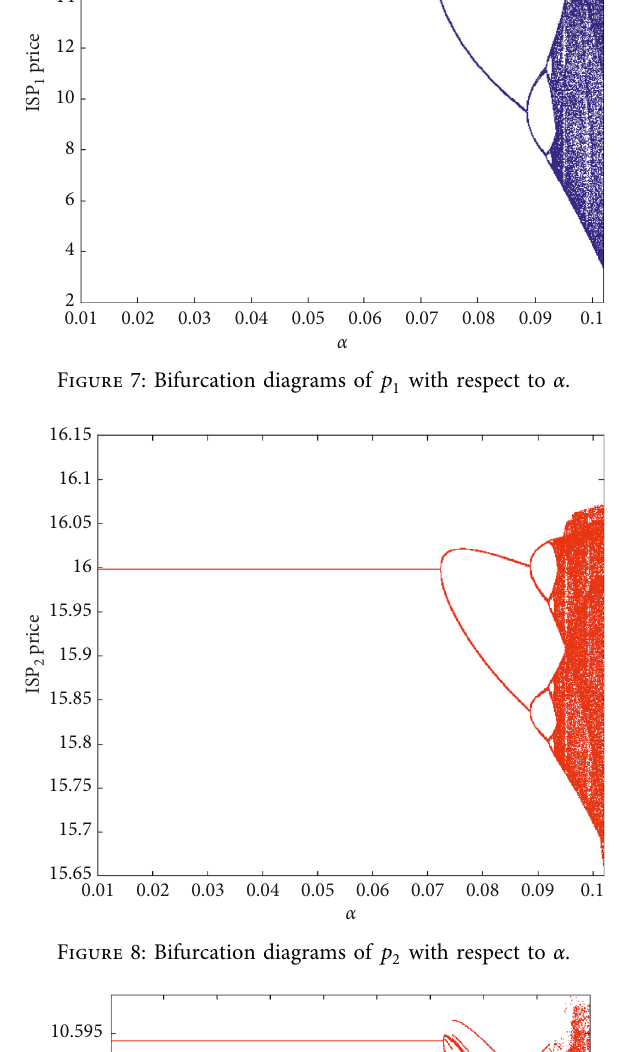
with respect to p t 1